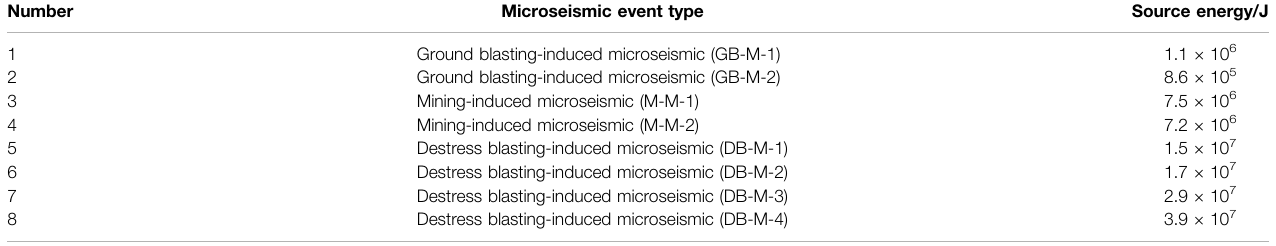
TABLE 1 | Information of induced microseismic events.